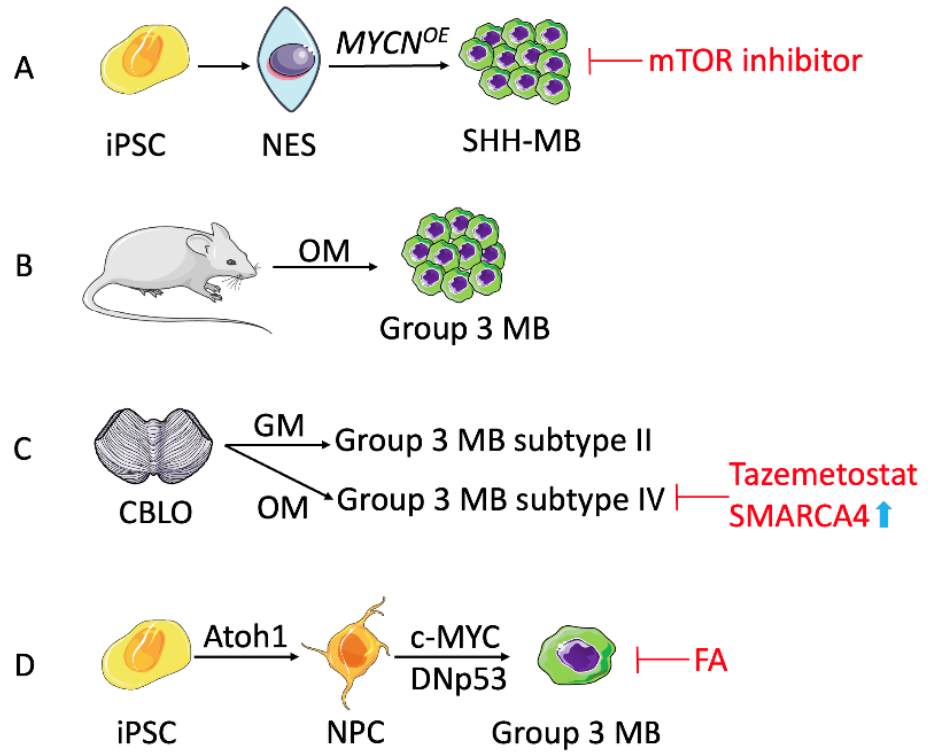
Figure 4. Generating SHH-medulloblastoma and Group 3 medulloblastoma tumor models. ( A ) SHH-MB induction from iPSCs. By transducing the MYCN gene into iPSC-derived NES (neuroepithelial stem) cells and then transplanting the NES cells into mice, SHH-MB tumors were produced. LGALS1 is highly expressed in both NES cells and SHH-MB tumor samples. mTOR inhibitor is a potential drug for SHH-MB. ( B ) Mice overexpressing OM developed Group 3 MB. ( C ) GM overexpression in iPSC-derived cerebellar organoids (CBLO) induced Group 3 MB subtype II, which had a higher risk than that of OM. Tazemetostat and SMARCA4 overexpression could inhibit OM-induced Group 3 MB. ( D ) Atoh1-coding mRNA induced rapid differentiation from iPSCs to NPCs. MYC over- expression and TP53 silencing made NPC differentiate into aggressive Group 3 MB, and frondoside A (FA) may rescue it. OM, OTX2+c-MYC overexpressing; GM, GFI1+c-MYC